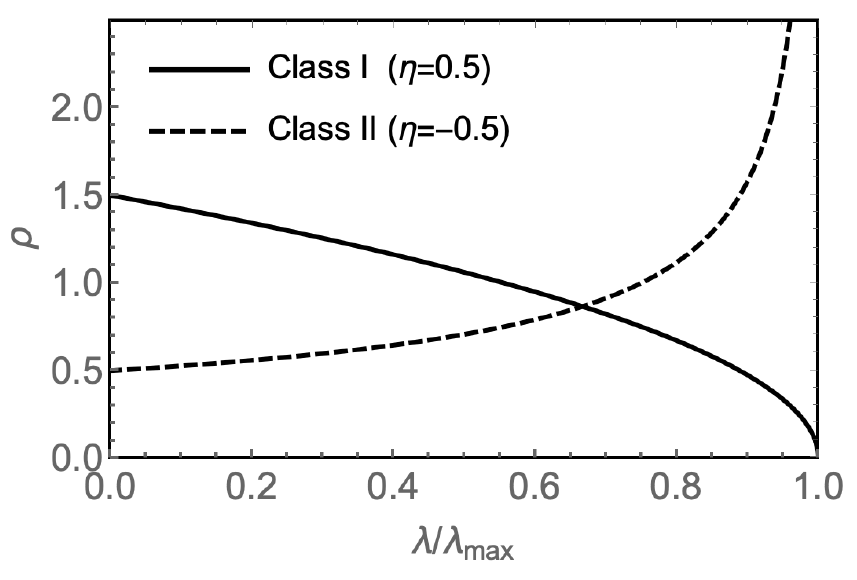
Figure 1: Model distributions of the variances ρ η ( λ ) for the Yukawa-SYK model. Depending on the sign of η , the class I ( η > 0) and class II ( η < 0) distributions show qualitatively different behaviour at λ = λ